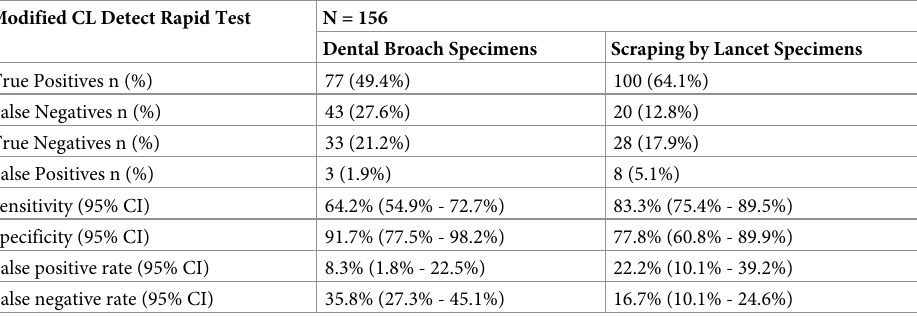
Table 3. Modified CL Detect Rapid Test Sensitivity and Specificity